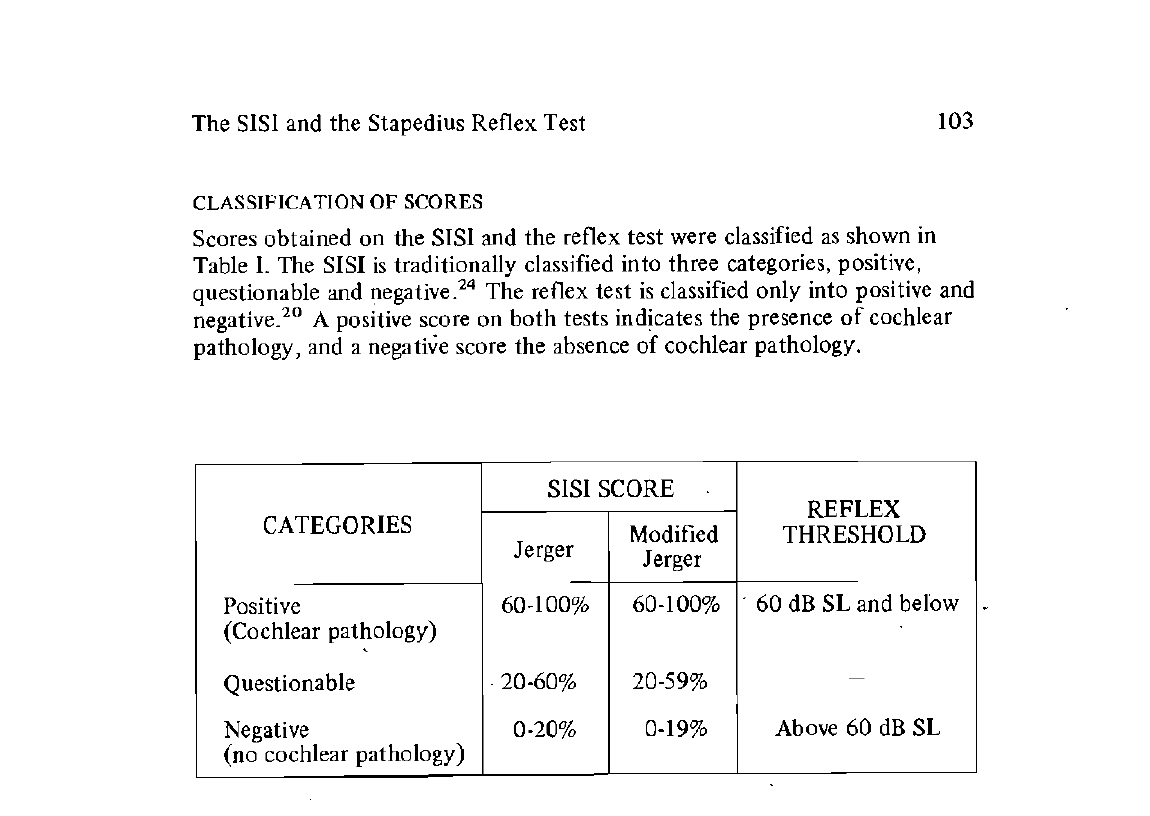
TABLE I: Method of Test Score